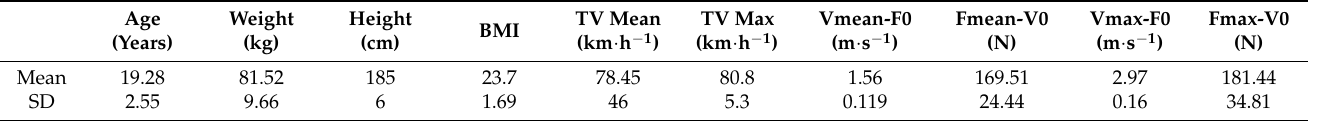
Table 1. Descriptive characteristics of participants.